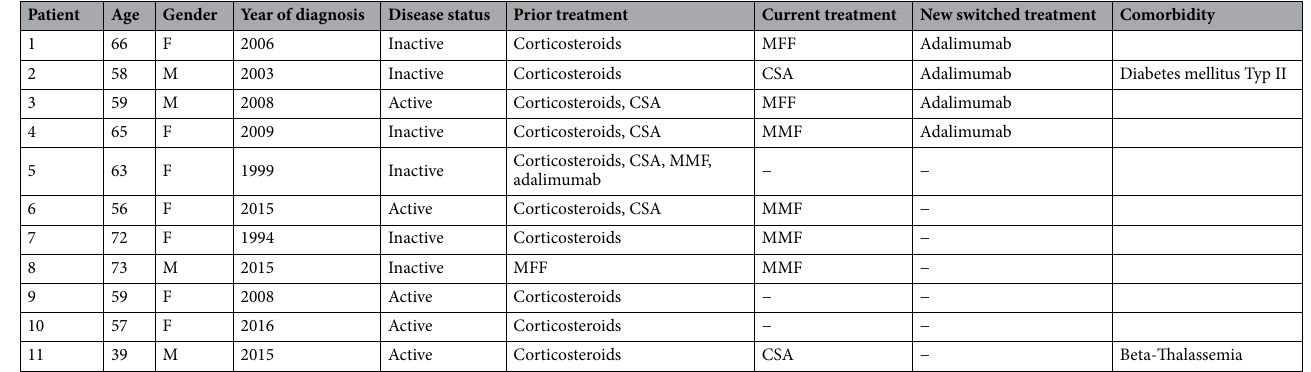
Table 1. Patients characteristic. CSA ciclosporine A, MFF mycophenolate